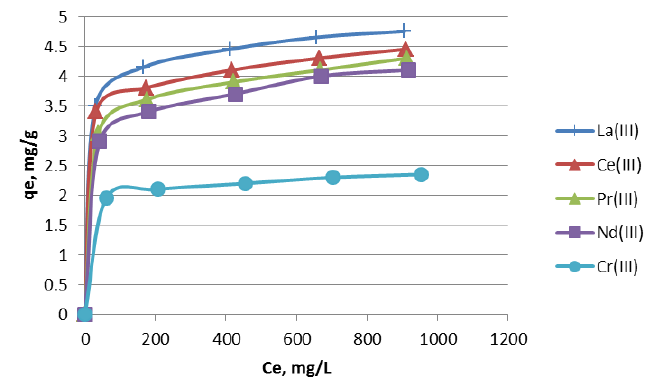
Figure 4. The isotherms of La(III), Ce(III), Pr(III), Nd(III) and Cr(III) ions sorption on Nitrolite.